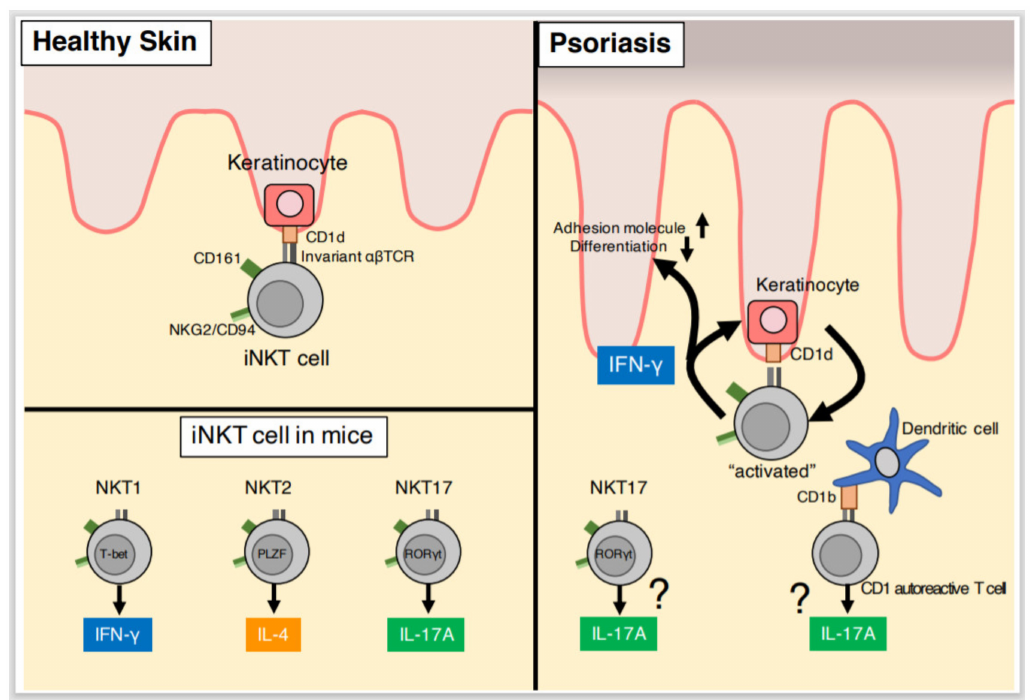
Figure 3. Role of natural killer T (NKT) cells in psoriasis. In psoriatic lesions, CD1d is widely expressed on keratinocytes in all layers of the epidermis. Keratinocyte CD1d expression is induced by interferon- γ (IFN- γ ), which is produced by CD94 + / CD161 + NKT cells. The interaction between NKT cells and CD1d expressed on keratinocytes could contribute to